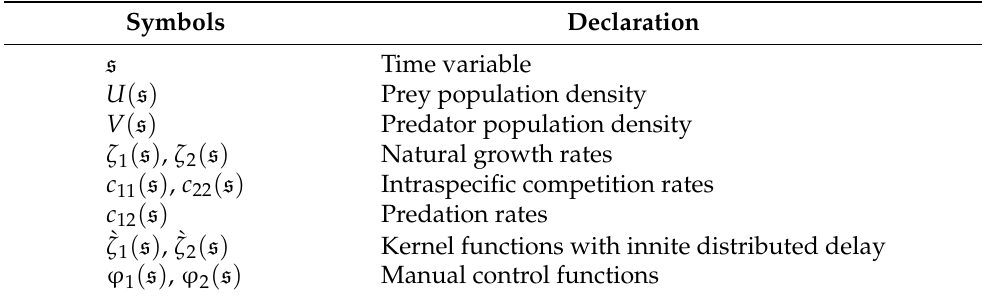
Table 1. The declaration of the symbols in system